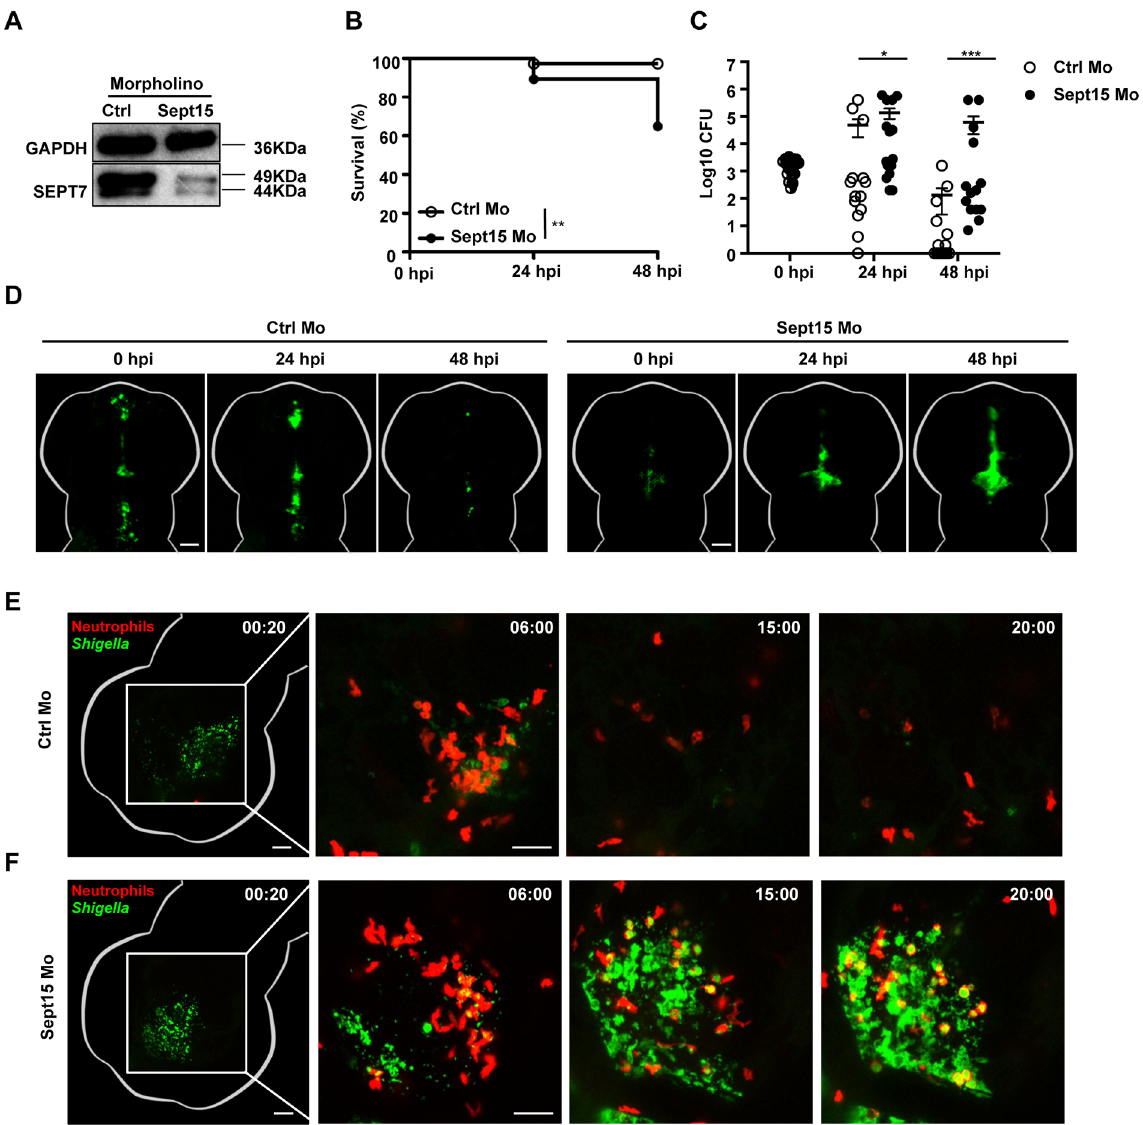
Fig 2. Sept15 morphants show increasedsusceptibility to S . flexneri infection. A. Representative western blot of extracts from larvaeinjected with control (Ctrl) or Sept15 morpholino (Mo) using antibodiesagainst GAPDH (as control) or SEPT7. B. Survival curves of Ctrl or Sept15 morphants infected with S . flexneri M90T (low dose). Pooleddata from 3 independentexperiments per treatment using at least 15 larvaeper treatment. Significance testing performed by Log Rank test. ** , P < 0.01. C. Enumerationof bacteriaat 0, 24, or 48 hpi from Ctrl (open circles) or Sept15(closed circles) morphantsinfected with S . flexneri M90T (low dose). Half-filled circles represent enumerations from larvaeat time 0 and are representative of inoculumsfor both conditions. Pooleddata from 3 independentexperiments using up to 3 larvae per treatment. Circles representindividuallarvae, and only larvae having survived the infection(thus far) includedhere (i.e., dead larvae not homogenised for counts). Mean ± SEM also shown (horizontal bars). Significancetesting performed by Student’st test. * , P < 0.05; *** , P < 0.001.D. Representative images of larvae injectedwith Ctrl or Sept15 Mo and infected in the HBV with GFP- S . flexneri M90T (low dose). For each treatment, the same larva was imaged at 0, 24, and 48 hpi using a fluorescent stereomicroscope. Scale bars, 100 μ m. See also S4 and S5 Videos. E-F. Representative frames extracted from in vivo time-lapse confocalimagingof lyz :dsRedlarvae (3 dpf, red neutrophils)injectedwith (E) Ctrl or (F) Sept15 Mo and infected in the HBV with GFP- S . flexneri M90T (low dose). First frame 20 mpi, followedby frames at 6, 15, and 20 hpi. Maximum intensity Z-projection images (2 μ m serial opticalsections) are shown. Scale bars, 50 μ m. See also S6 and S7 Videos.